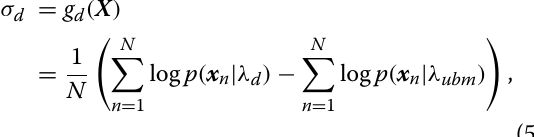
The log-mel spectrogram is a popular signal parametriza- tion technique in many audio applications using deep neural networks which provides an efficient, perceptually relevant, 2-dimensional representation of an audio signal. Compared to the STFT, the log-mel spectrogram provides a less redundant representation of an audio signal and allows CNNs to learn with a smaller number of training data. The decibel scaling is motivated by the human per- ception of loudness [23] and has shown to provide a better discriminability compared to the linear version [24]. The resulting log-mel spectrogram together with the first-